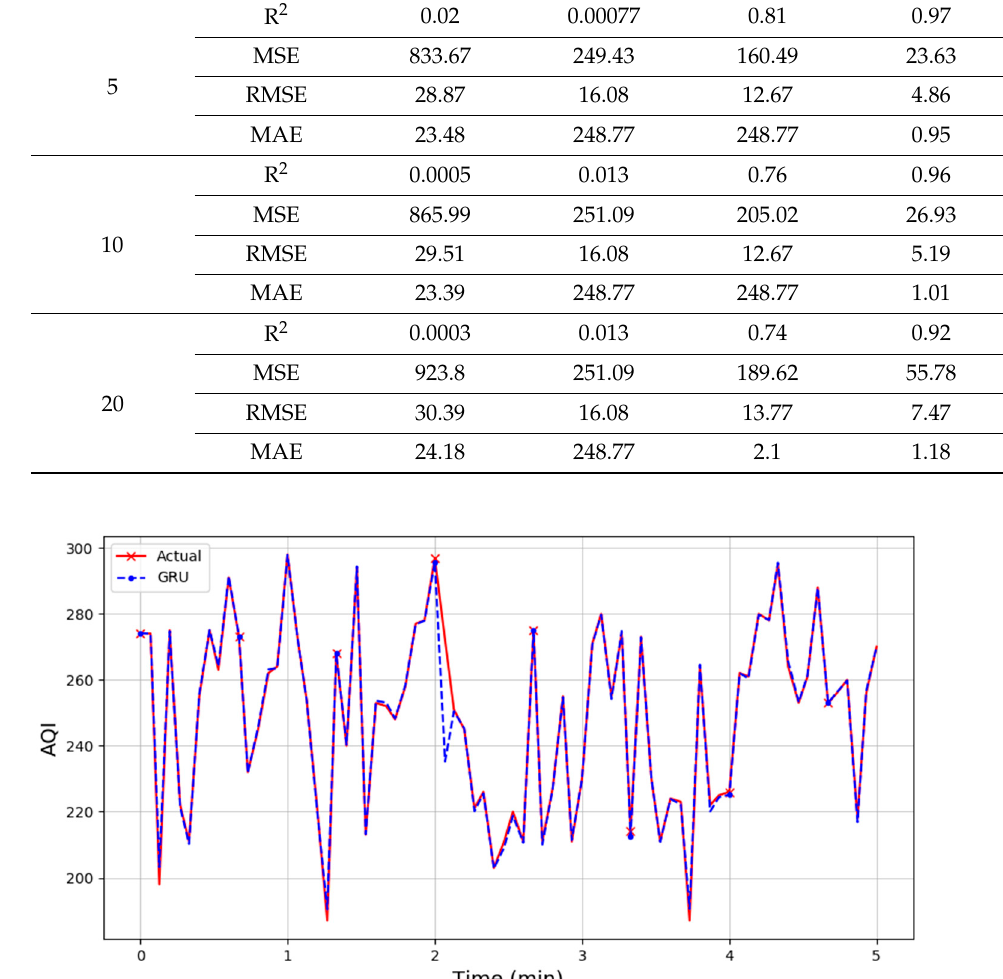
Table 8. Results of Prediction Data for Three Types of data.